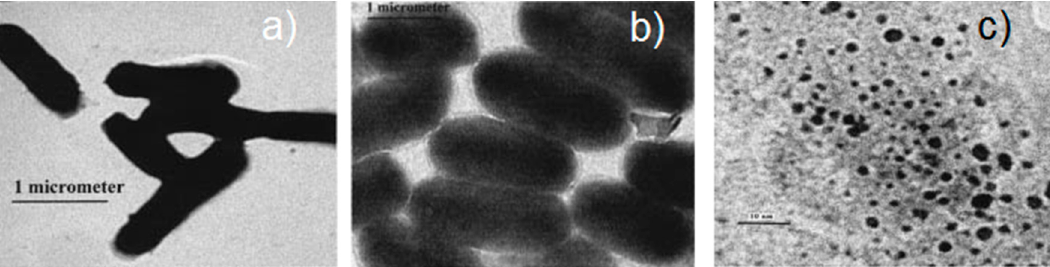
Figure 53. TEM of Escherichia coli with Ag colloid deposited on the bacterial wall ( a ), with Ag internal colloids ( b ), and with internal colloids released also into solution from damaged cells ( c ). Reproduced with permission from Efrima et al. [466]. Copyright (1998), the American Chemical Society.